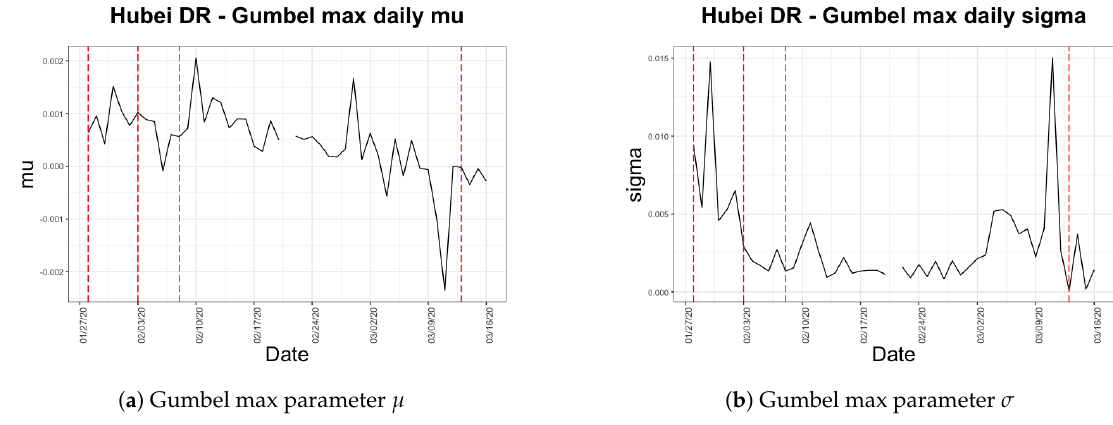
Figure 9. Time series for Hubei death rate Gumbel max